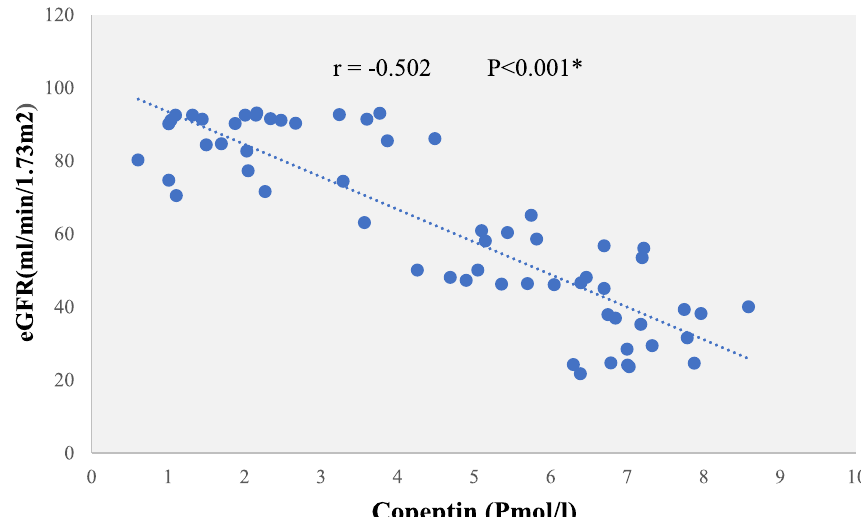
Fig. 2 Correlation between copeptin level and eGFR in type 2 diabetic patients ( n negative correlation between copeptin level with eGFR. Abbreviations: eGFR; Estimated Glomerular filtration rate, r: Pearson’s correlation coefficient, *: Statistically significant ( p 0.05) ≤